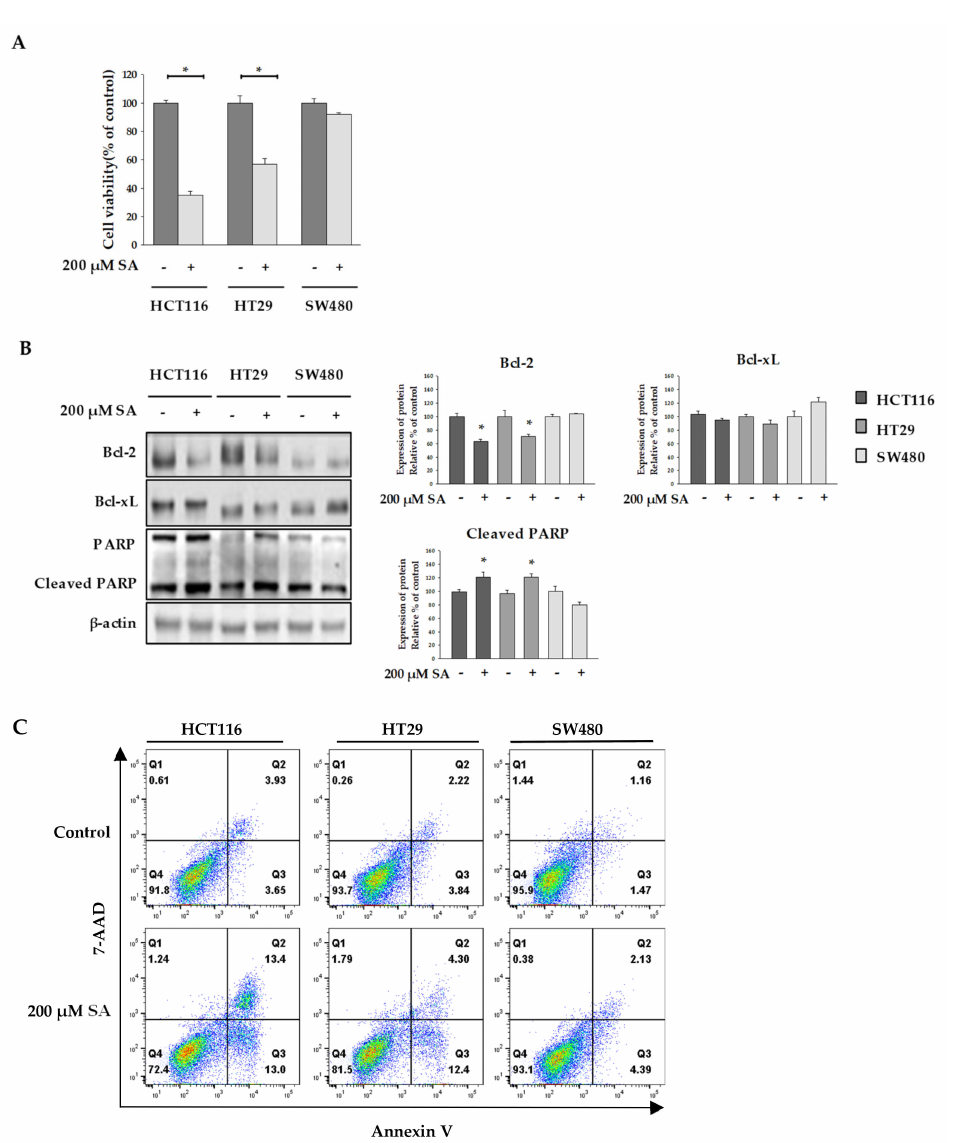
Figure 1. E ff ect of succinylacetone (SA) to viability of colon cancer cells. HCT116, HT29, and SW480 cells were treated with 200 µ M SA for 48 h. ( A ) MTT assay was performed to assess cell viability. ( B ) Expression of Bcl-2, Bcl-xL, and cleaved-PARP was detected by Western blotting. β -actin was reprobed as a loading control. ( C ) Cells were incubated with 200 µ M of SA for 48 h and subsequently stained with Annexin-V / PI. Data are representative values of three independent experiments and expressed as mean ± SD ( n = 3), * p <